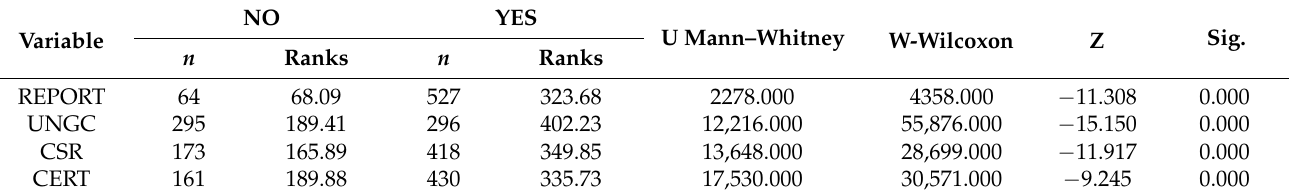
Table 6. The results of U Mann–Whitney test for sustainability policy